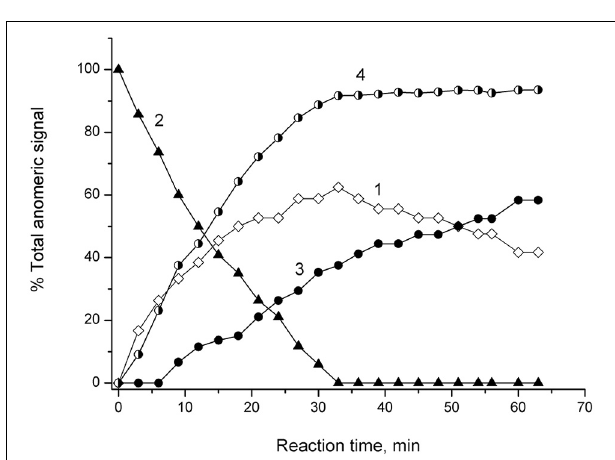
FIGURE 4 | 1 H NMR Monitoring of reaction of α -4-NPGP hydrolysis catalyzed by α - Ps Gal in 50mM sodium phosphate buffer pH 7.5, at 20 ◦ C, D 2 O. Experimental time-dependent changes in integral intensity of anomer signals. Curve 1: α H-1 of reaction product of galatopyranose at 5.26ppm; Curve 2: α H-1 of 4-NPGP at 5.84ppm; Curve 3: β H-1 mutarotation product of α -galatopyranose at 4.57ppm; Curve 4: shows the change in the degree of hydrolysis of the substrate vs.